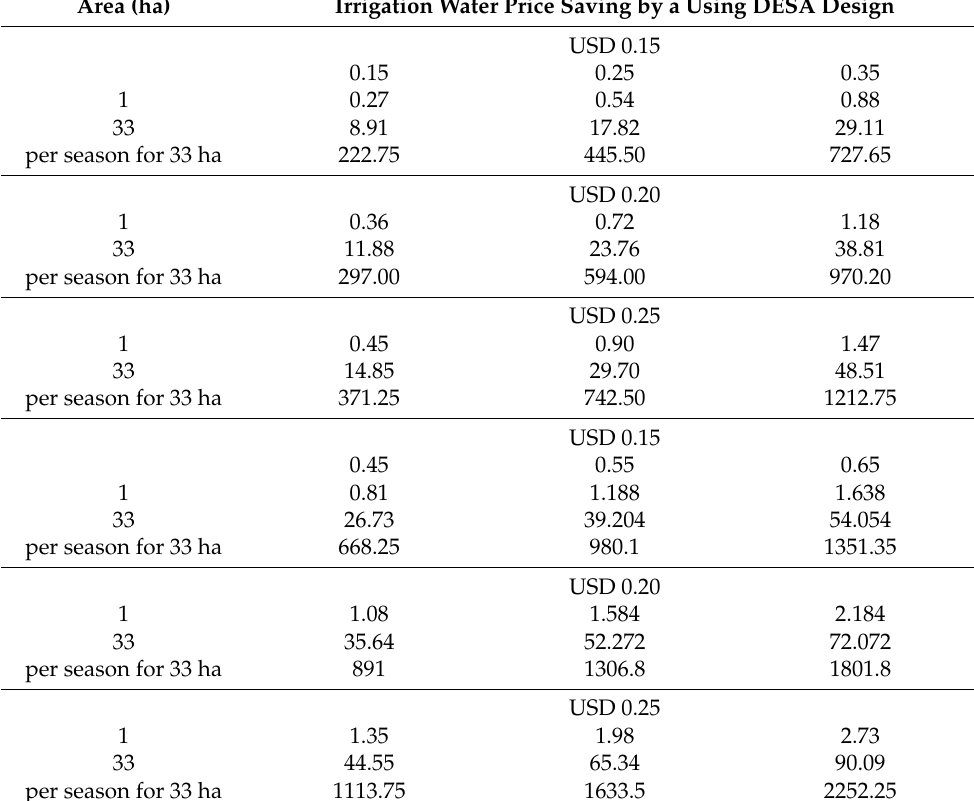
Table 7. Irrigation water price saving by a DSEA design during an irrigation event with climate